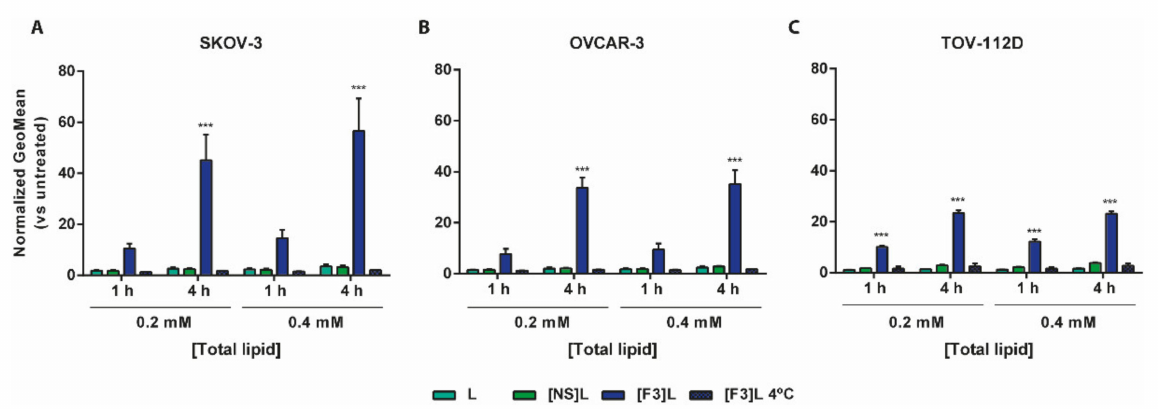
Figure 2. Cellular association of F3 peptide-targeted liposomes by ovarian cancer cell lines. Cells were incubated with 0.2 or 0.4 mM (total lipid) of rhodamine-labelled liposomes functionalized with F3 peptide ([F3]L) or non-specific peptide ([NS]L) or non-targeted (L) for 1 or 4 h, at 37 or 4 ◦ C. The normalized (vs. untreated) rhodamine geometric mean fluorescence for ( A ) SKOV-3, ( B ) OVCAR-3 and ( C ) TOV-112D ovarian cell lines is represented. Data represent mean ± SEM ( n = 3; two-way ANOVA; *** p < 0.001 Bonferroni’s